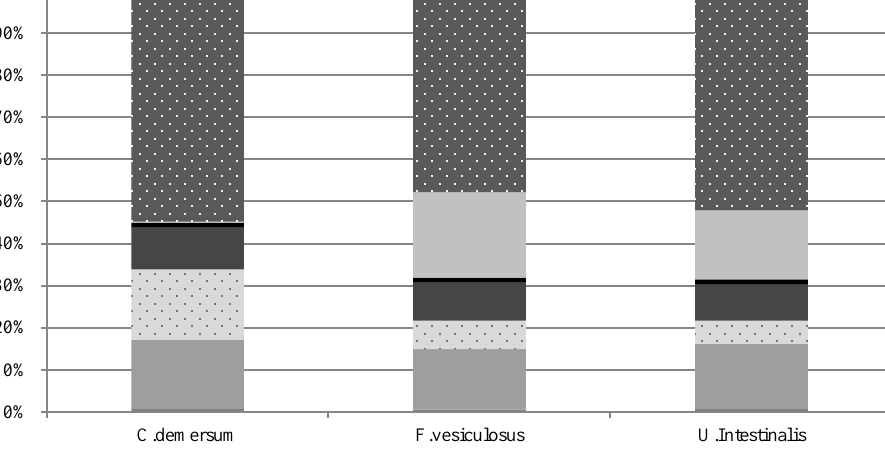
Fig. 3. Costs structure of